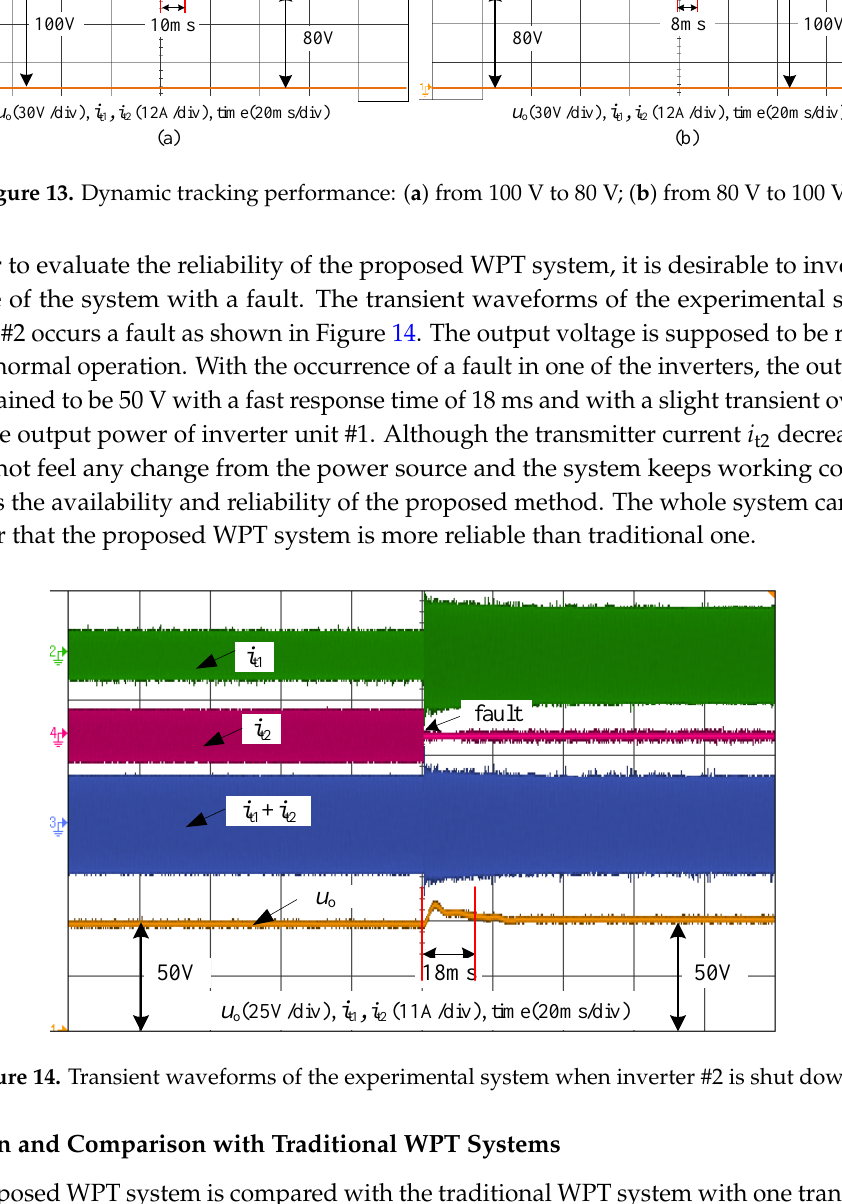
Figure 14. Transient waveforms of the experimental system when inverter #2 is shut down.